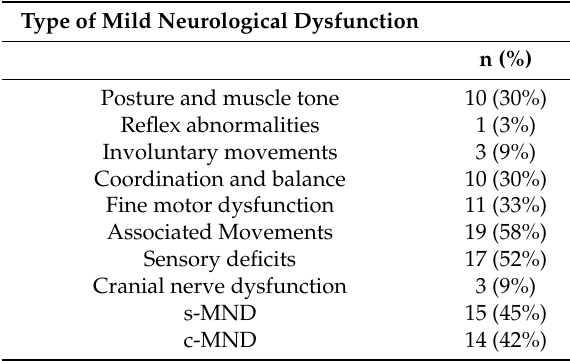
Table 2. Prevalence of the specific types of MND in ASD